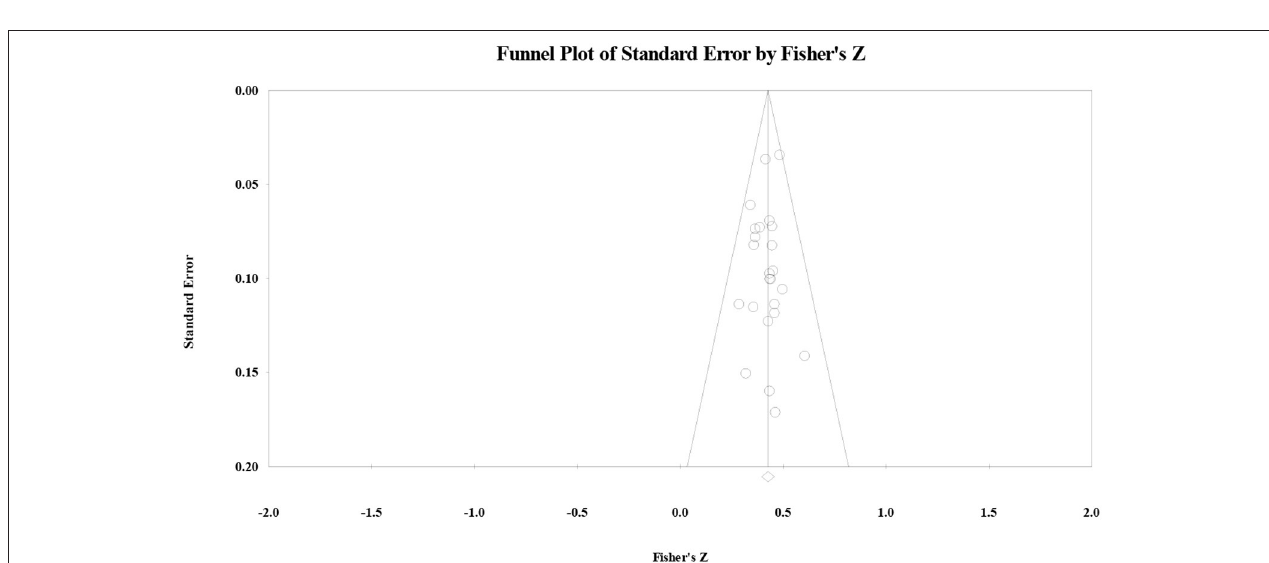
FIGURE 1 | Funnel plot of the correlation between the affective strategy and reading comprehension.